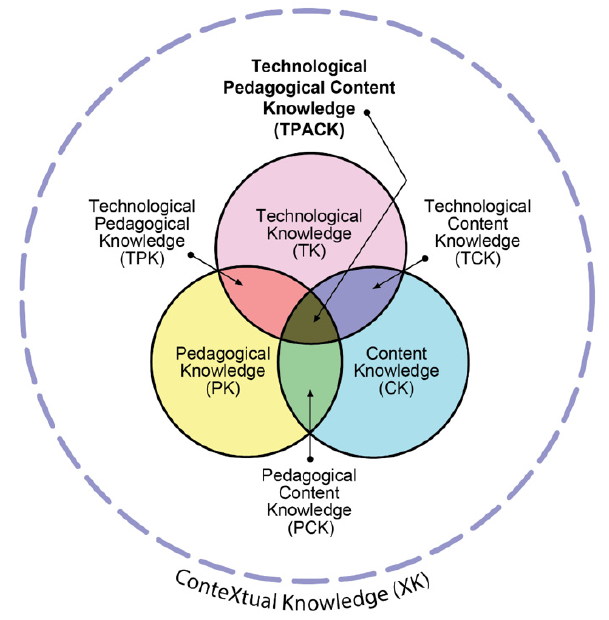
Figure 1. TPACK model